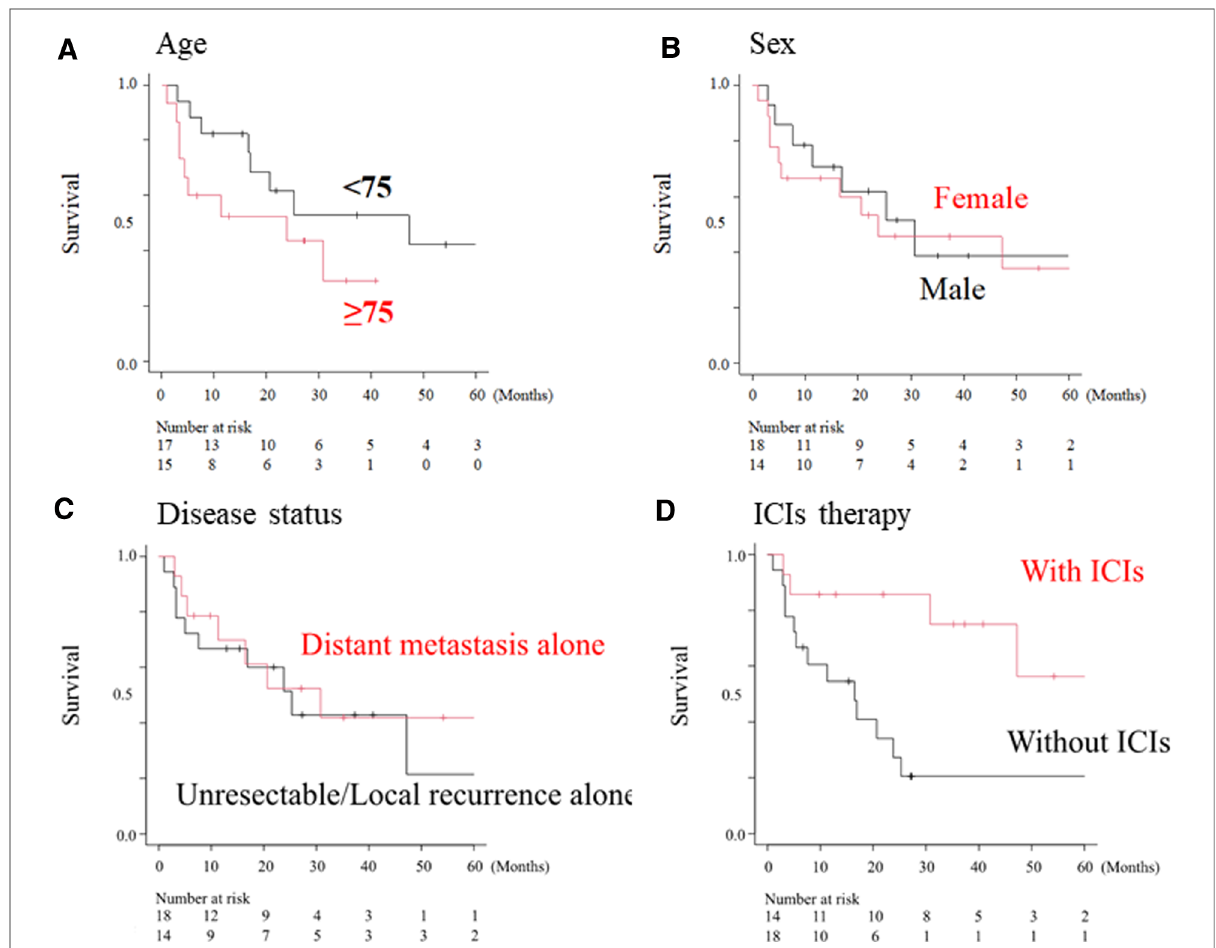
FIGURE 3 Overall survival curve according to clinical factors. Overall survival according to sex ( A ), age ( B ), disease status ( C ) and ICI treatment ( D ). The median overall survival in patients who received ICI therapy (with ICI) was signi fi cantly longer than that in patients without ICIs (without ICI group) (not reached vs. 11.3 months, p